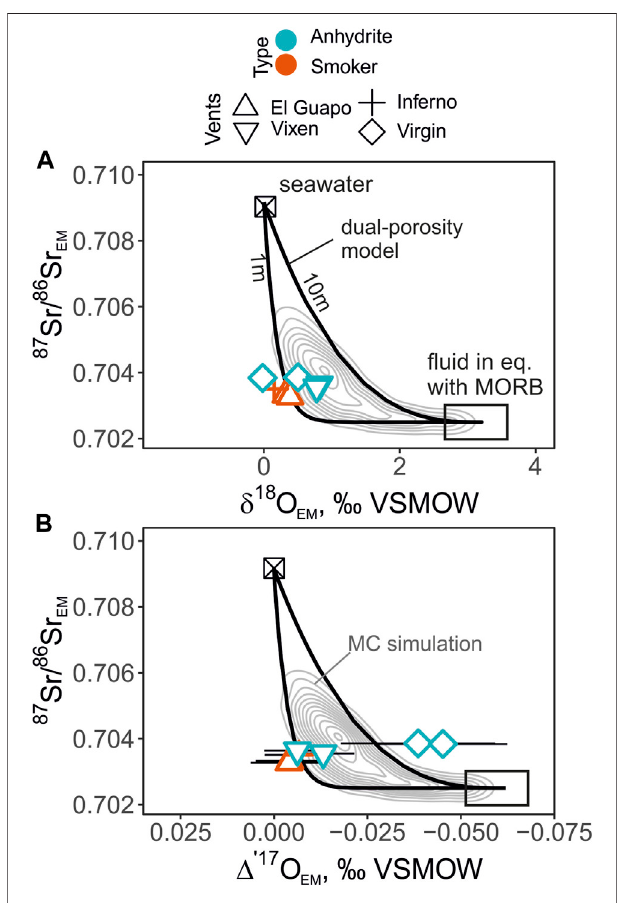
FIGURE 7 | The endmember δ ′ 18 O values (A) and Δ ′ 17 O values (B) plotted against 87 Sr/ 86 Sr. The panels show the pro fi les of the dual-porosity model at fracture spacing of 1 and 10 m along with the Monte-Carlo simulation outputs depicted with the 2D density distribution (concentric grey lines). The individual endmember isotope values are shown except the Diva vent fl uids due to the possible effect of anhydrite precipitation. The fl uids from the Virgin vent have a large uncertainty in the endmember Δ ′ 17 O values due to the zero-Mg-correction, and plot outside the predicted contours. The uncertaintiesofthemean 87 Sr/ 86 Sr EM valuesaresmallerthanthesymbolsizes in these